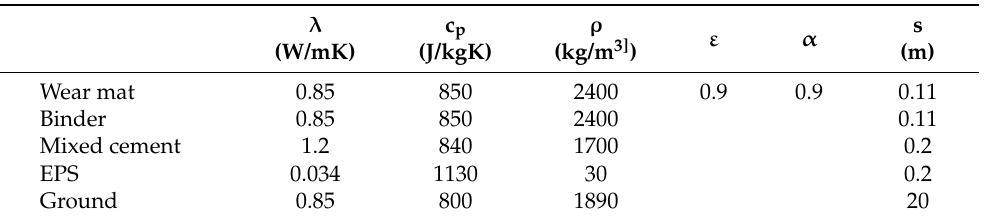
Table 7. Thermophysical properties of the stratigraphy to be carried out in the experimental area above the